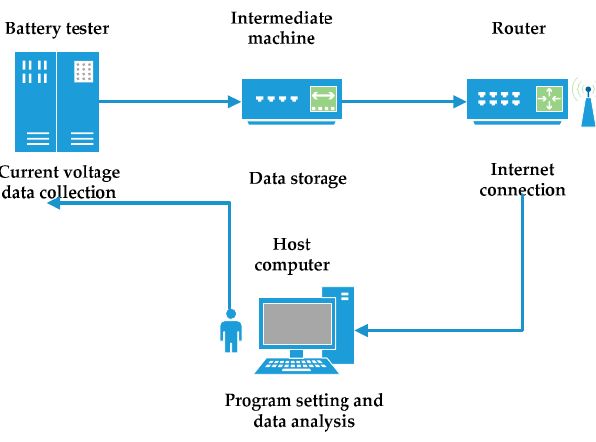
Figure 2. NEWARE BTS4000 battery testing bench.